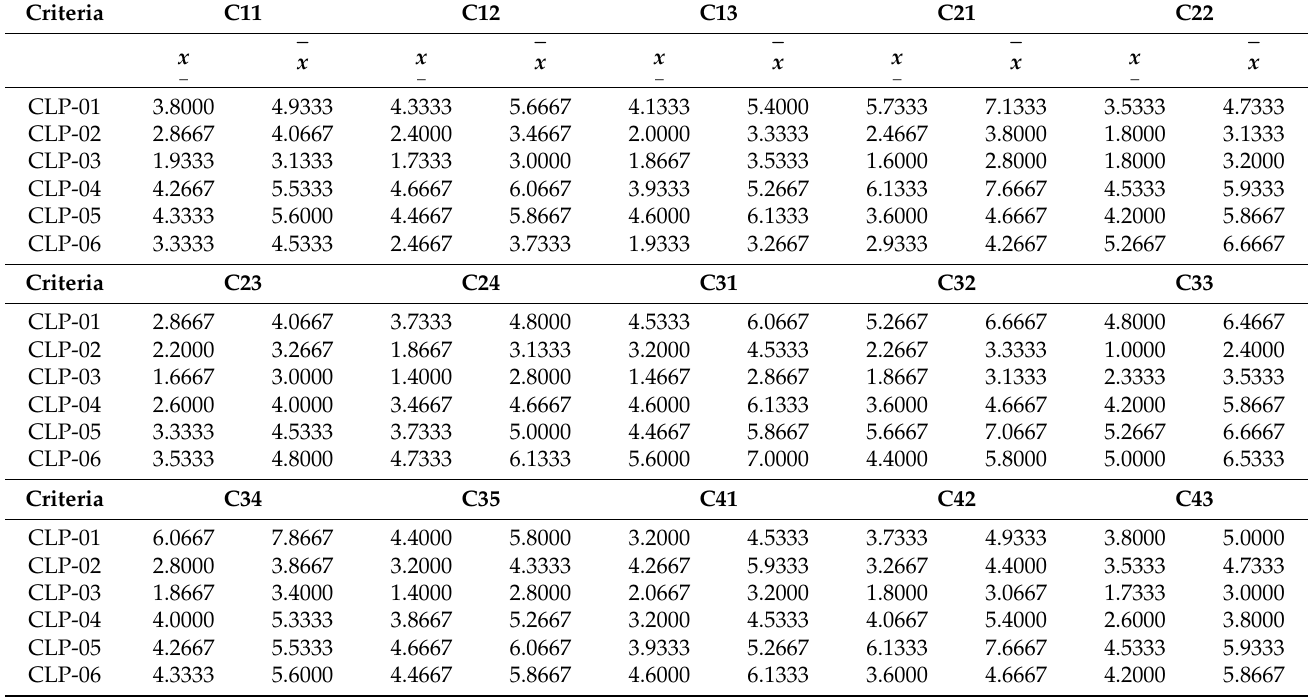
Table A2. The integrated grey decision matrix of the